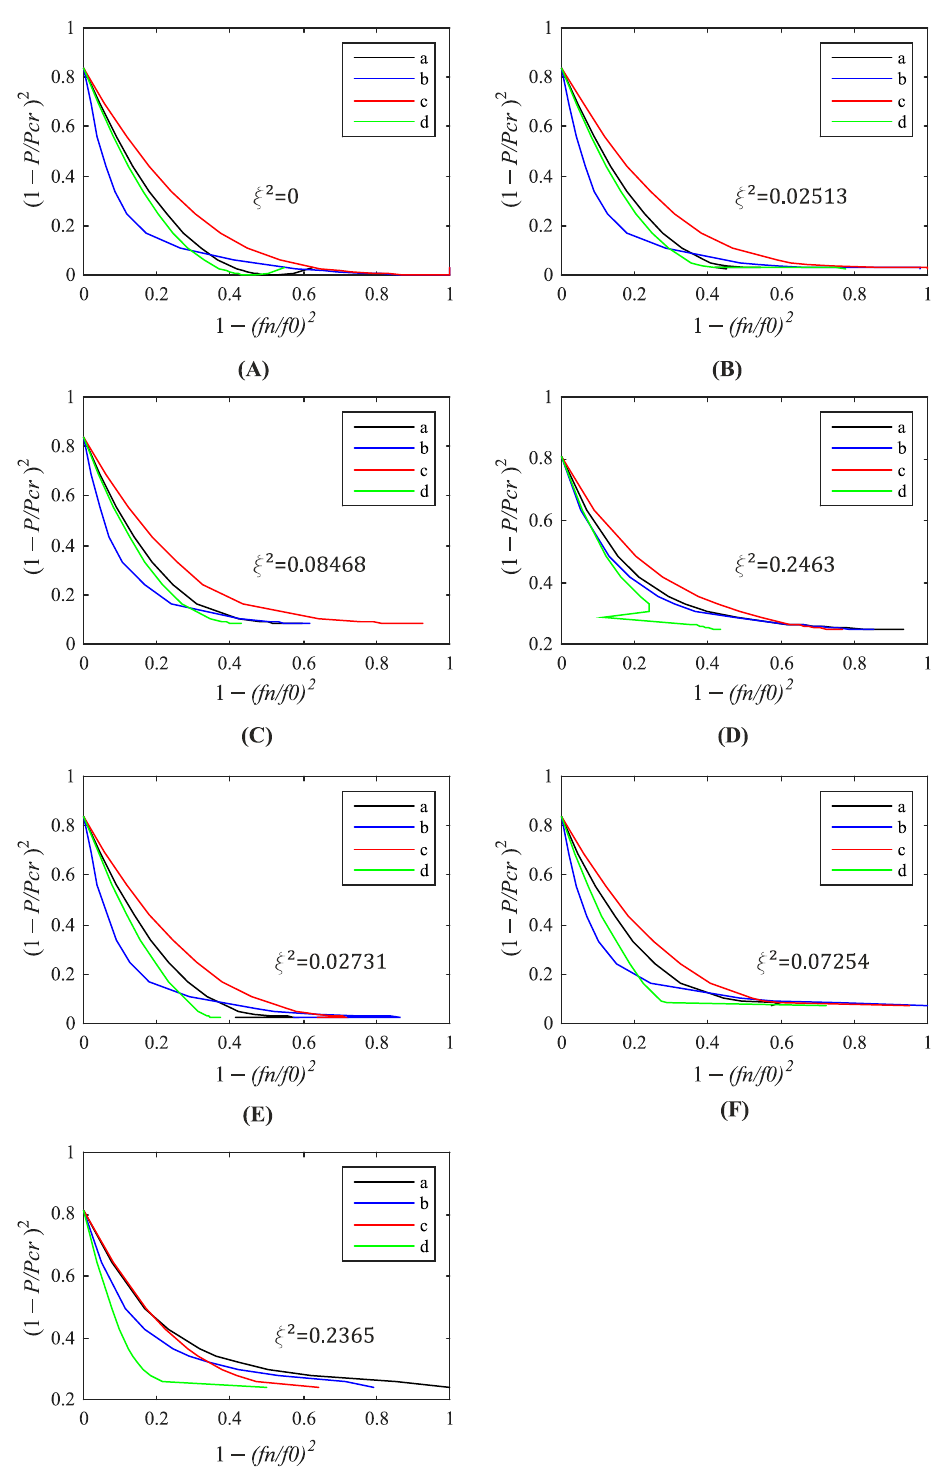
Figure 11. Relationship between relative load and natural frequencies ((a) first, (b) second, (c) third, (d) fourth) of the silo segment with initial geometrical imperfections: ( A ) none, ( B ) B1_2 mm, ( C ) B1_5 mm, ( D ) B1_20 mm, ( E ) B2_2 mm, ( F ) B2_5 mm, ( G ) B2_20 mm, according to the modified VCT by Arbelo.